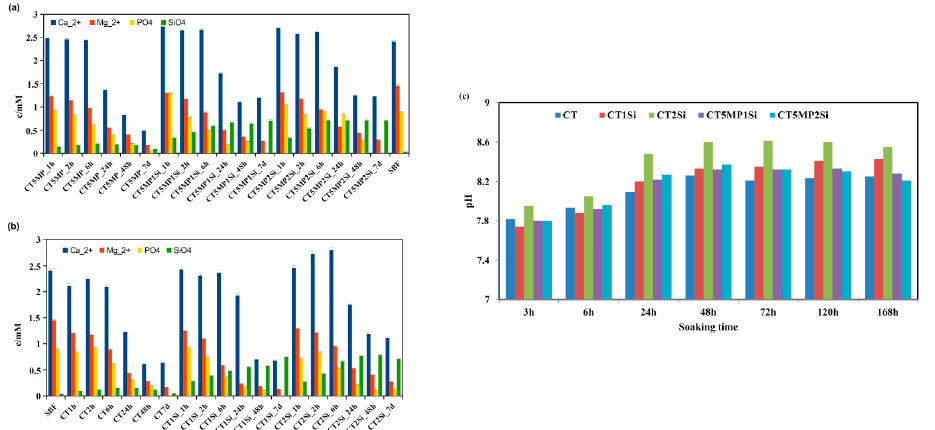
Figure 6. Release of Ca 2+ , Mg 2+ , silicate, phosphate ions ( a ) CT5MP, CT5MP1Si, CT5MP2Si, ( b ) CT, CT1Si, CT2Si and ( c ) change of pH during the soaking of cements in SBF at 37 °C.